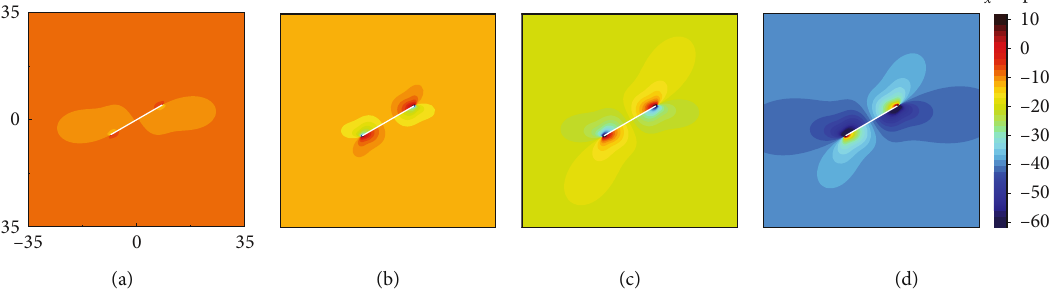
Figure 22: The contour plot of σ around the crack: (a) λ = 0 : 6 , Δ a / a = 0 : 33 ; (b) λ = 0 : 4 , Δ a / a = 0 : 50 ; (c) λ = 0 : 3 , Δ a / a = 0 : 67 ; and (d) λ = 0 : 2 x , Δ a / a = 1 .